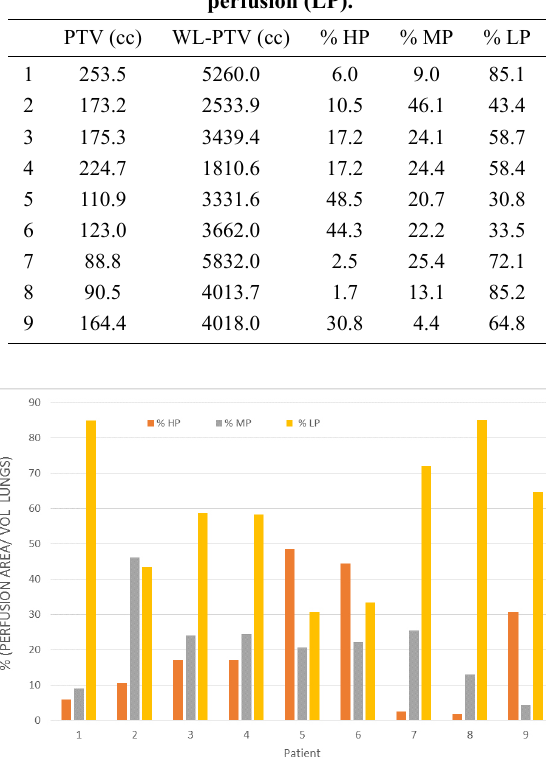
Table 3. Patients’ PTV and whole lung-PTV (WL-PTV) volume and percentage of the three different functional areas: high perfusion (HP), medium perfusion (MP), low perfusion (LP).